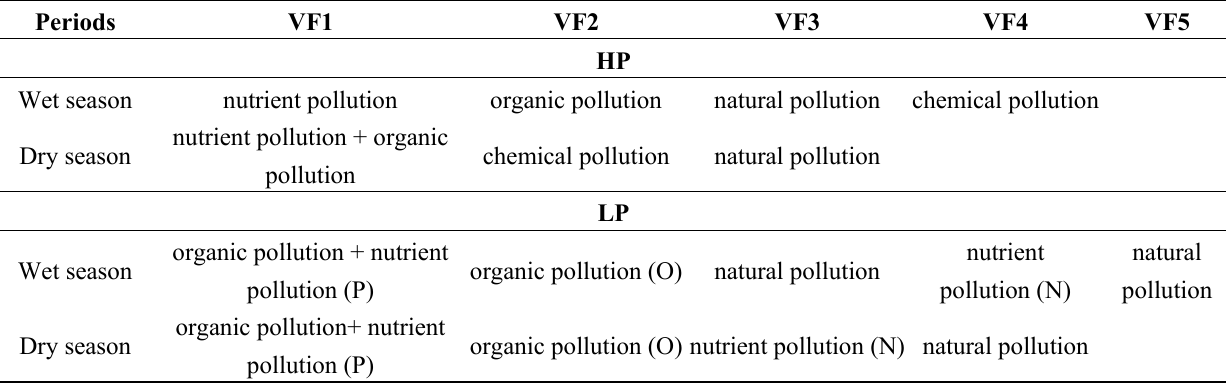
Table 8. Results of source identification at wet season and dry season in high pollution (HP) region and low pollution (LP)